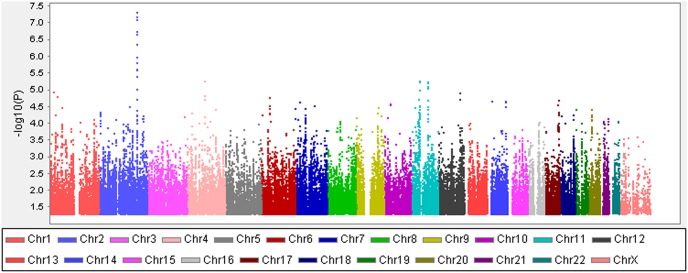
Manhattan plot of genome-wide association analysis for serum ferritin concentrations.X-axis shows chromosomal positions. Y-axis shows –log10 P-values from the linear regression adjusting for population stratification, age and BMI and stage information. Candidate gene names are showed for the significantly associated loci.